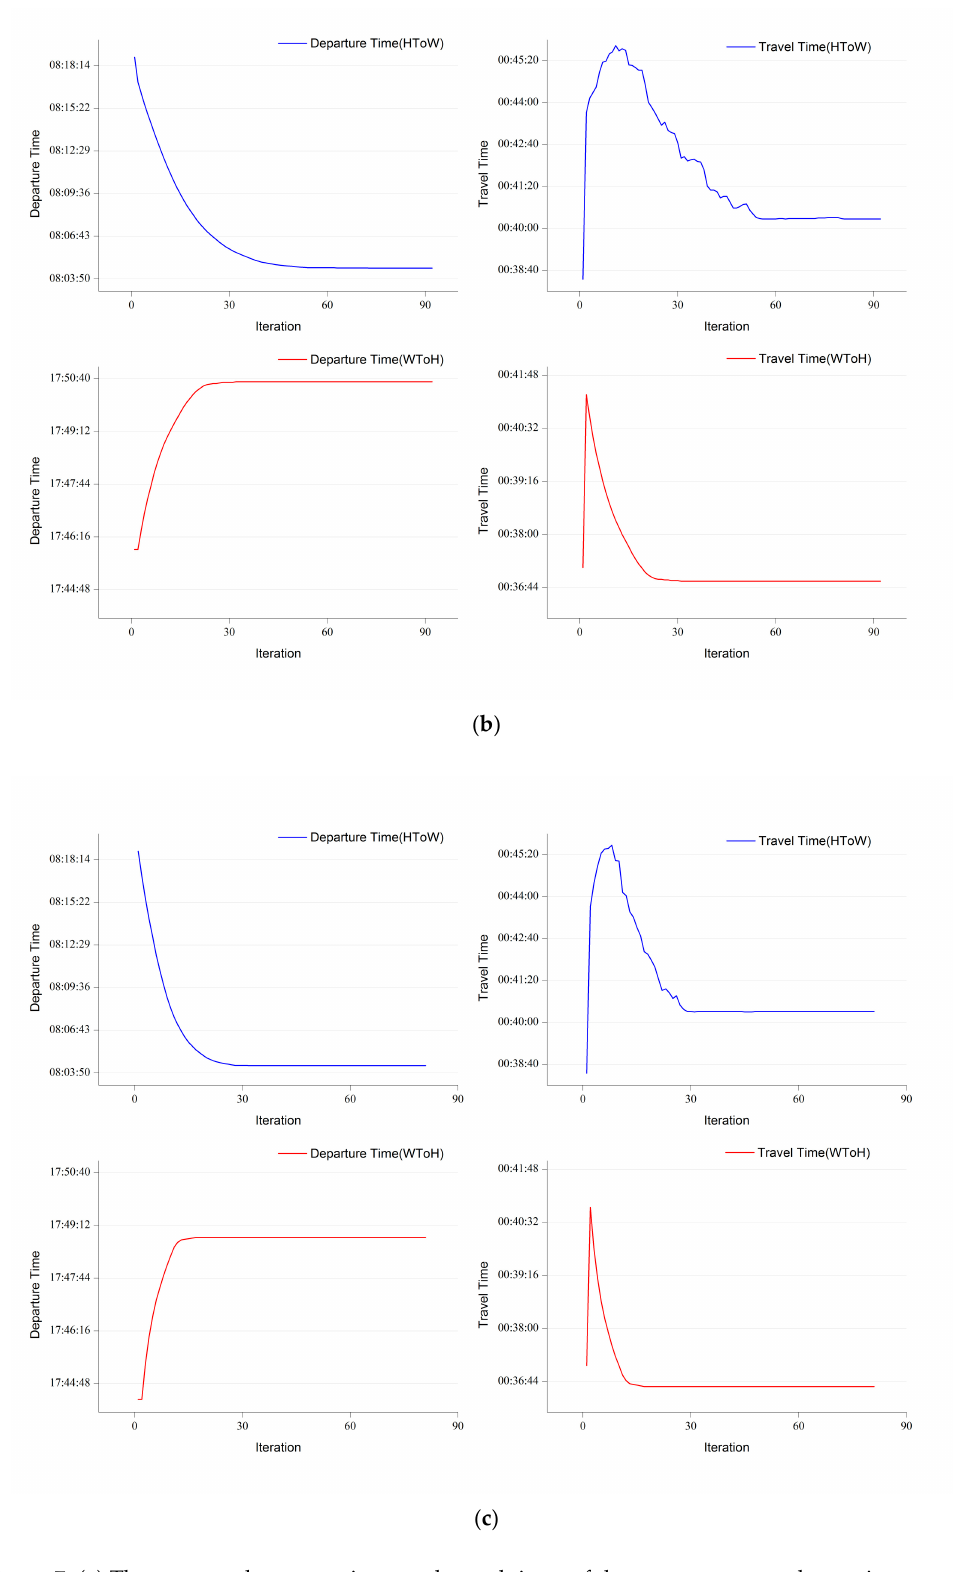
Figure 7. ( a ) The average departure times and travel times of the person agents when going to work and getting off work in each iteration for a 1-min step length ( η = 1 min); ( b ) The average departure times and travel times of the person agents when going to work and getting off work in each iteration for a 2-min step length ( η = 2 min); ( c ) The average departure times and travel times of the person agents when going to work and getting off work in each iteration for a 4-min step length ( η = 4